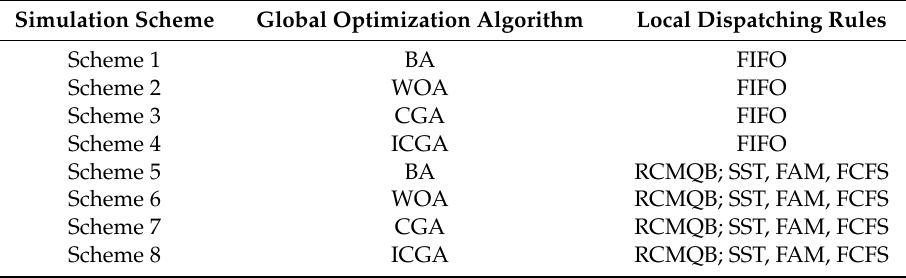
Table 7. The eight groups of the simulation